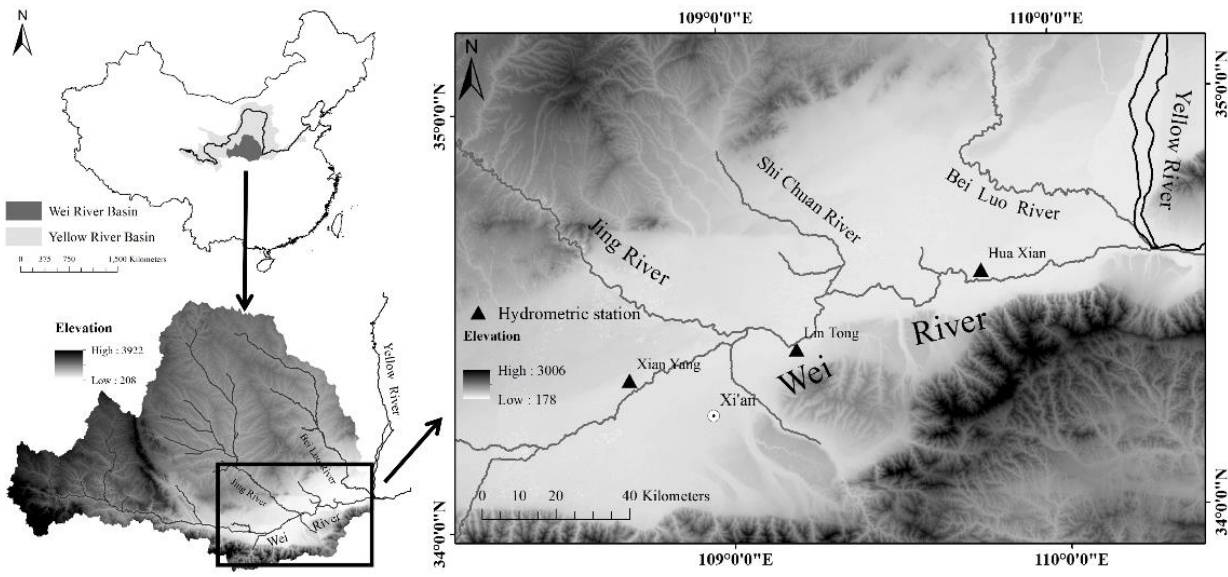
Figure 1. Schemes follow the same